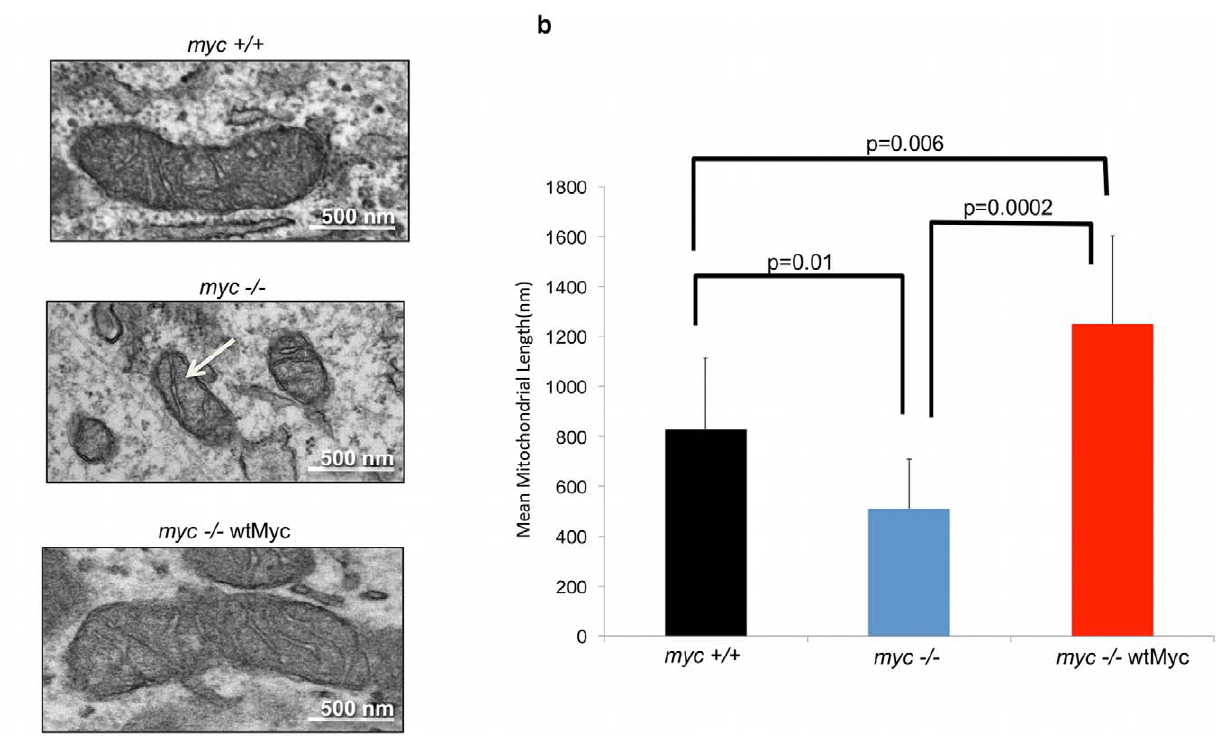
Figure 1. Levels of Myc affect mitochondrial structure in rat fibroblasts. ( a ) Mitochondrial ultrastructure . The indicated cell lines were examined by transmission electron microscopy. Representative mitochondria are presented. Note the smaller and cristae-deficient mitochondrion of the myc 2 / 2 cells (arrow) and the complete restoration of this defect in myc 2 / 2 wtMyc cells. ( b ) Mitochondrial length . Mean mitochondrial length in each cell line was determined by measuring at least 30 individual mitochondria from images of multiple cells obtained by transmission electron microscopy. The student t-test was used to calculate the p-values indicated in the figure.